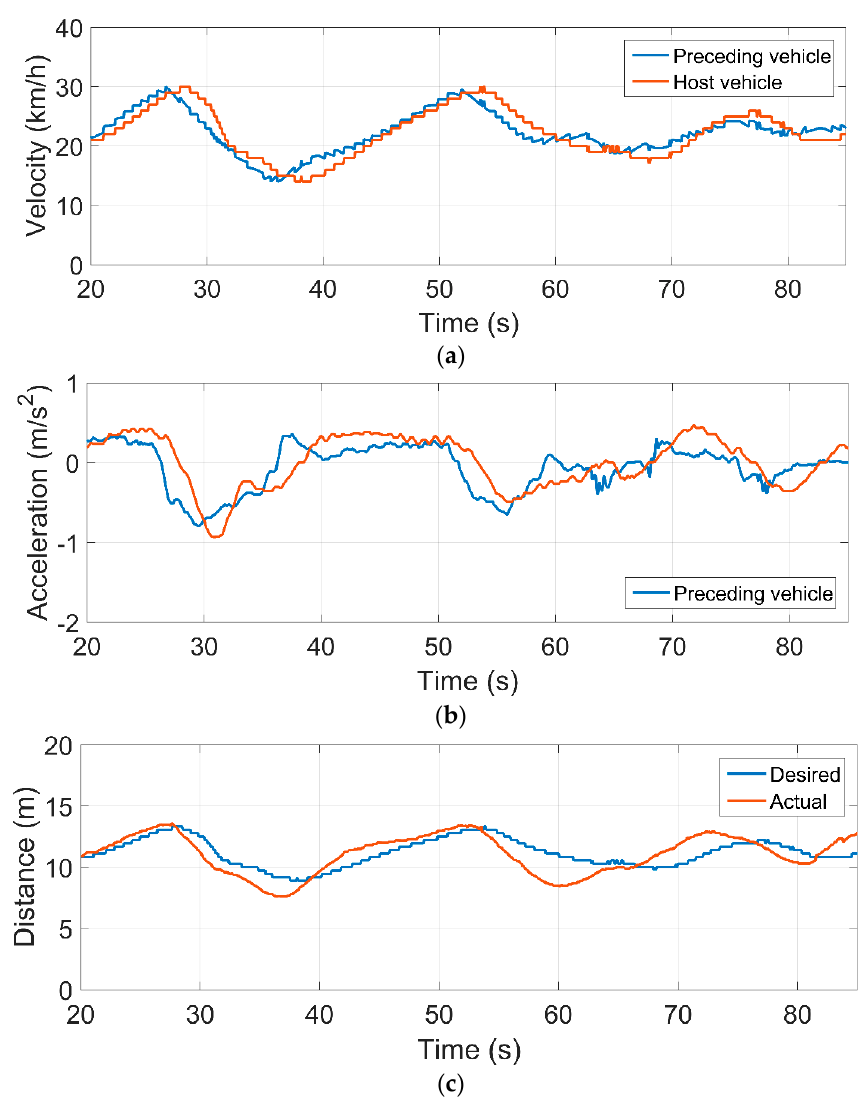
Figure 11. Test results with a 1.0-s time headway: ( a ) velocity, ( b ) acceleration, and ( c ) distance. Appl. Sci. 2018 , 8 , x FOR PEER REVIEW Table 5. Maximum, average, and variance of distance error, with the real driving cycle.